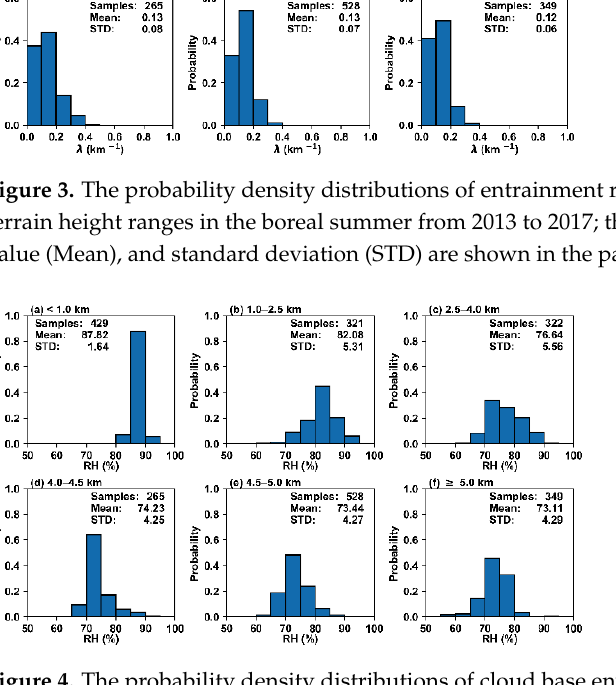
Figure 4. The probability density distributions of cloud base environmental relative humidity (RH; units: %) in the different terrain height ranges in the boreal summer from 2013 to 2017; the sample number (Samples), mean value (Mean), and standard deviation (STD) are shown in the panels.